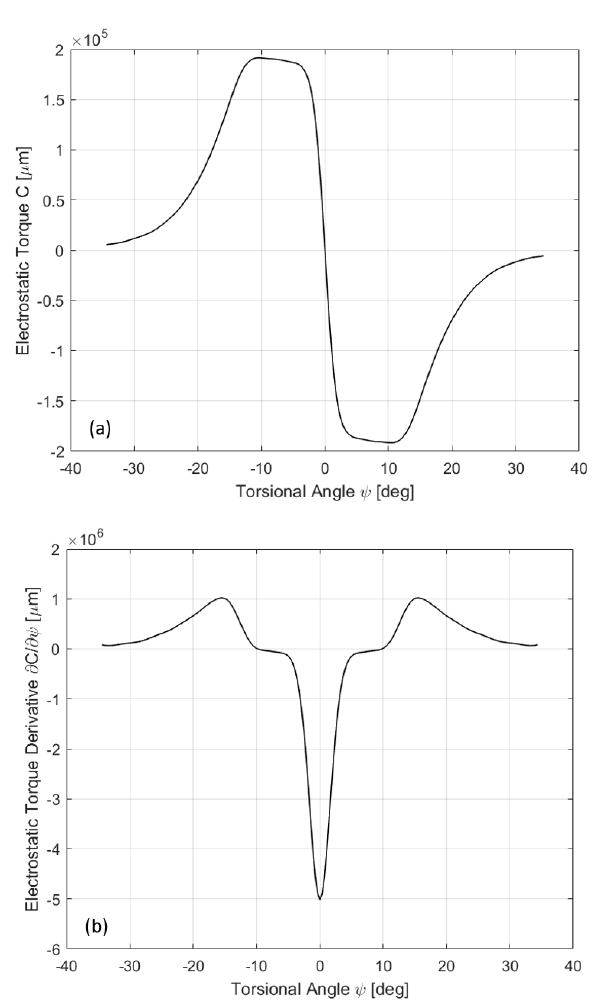
Figure 5. Electrostatic torque ( a ) and derivative of electrostatic torque ( b ) for one set of comb-fingers with respect the torsional angle ψ